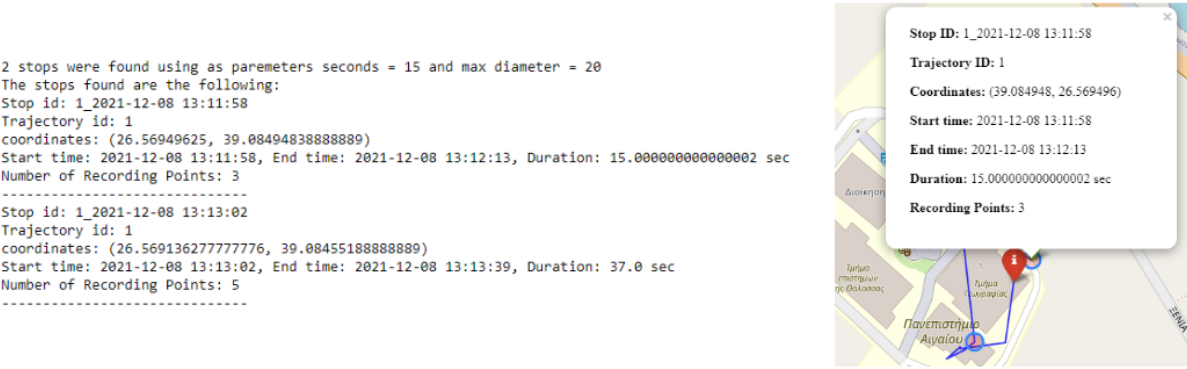
Figure 12. Detected stops of evaluated trajectories.